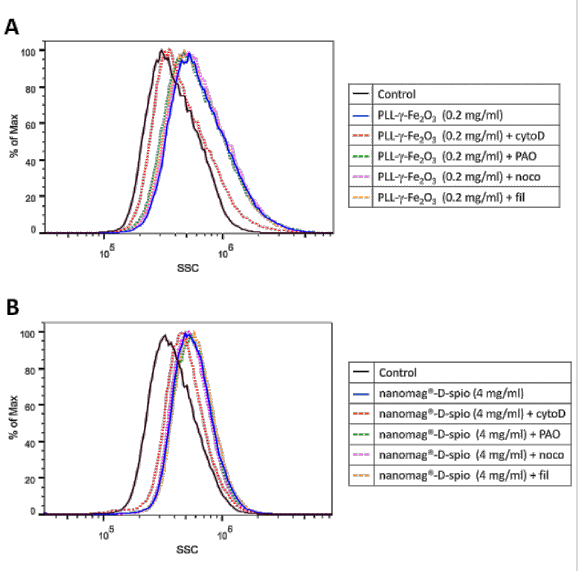
Figure 7: Macropinocytosis is the mechanism of cellular uptake of PLL- γ -Fe 2 O 3 and nanomag ® -D-spio nanoparticles. The internalization mechanism of PLL- γ -Fe 2 O 3 (A) and nanomag ® -D-spio (B) nanoparti- cles in NSCs measured by flow cytometry of side scatter (SSC) after treatment of NSCs with different inhibitors: phenylarsine oxide (PAO), cytochalasin D (cytoD), nocodazole (noco) and filipin (fil).